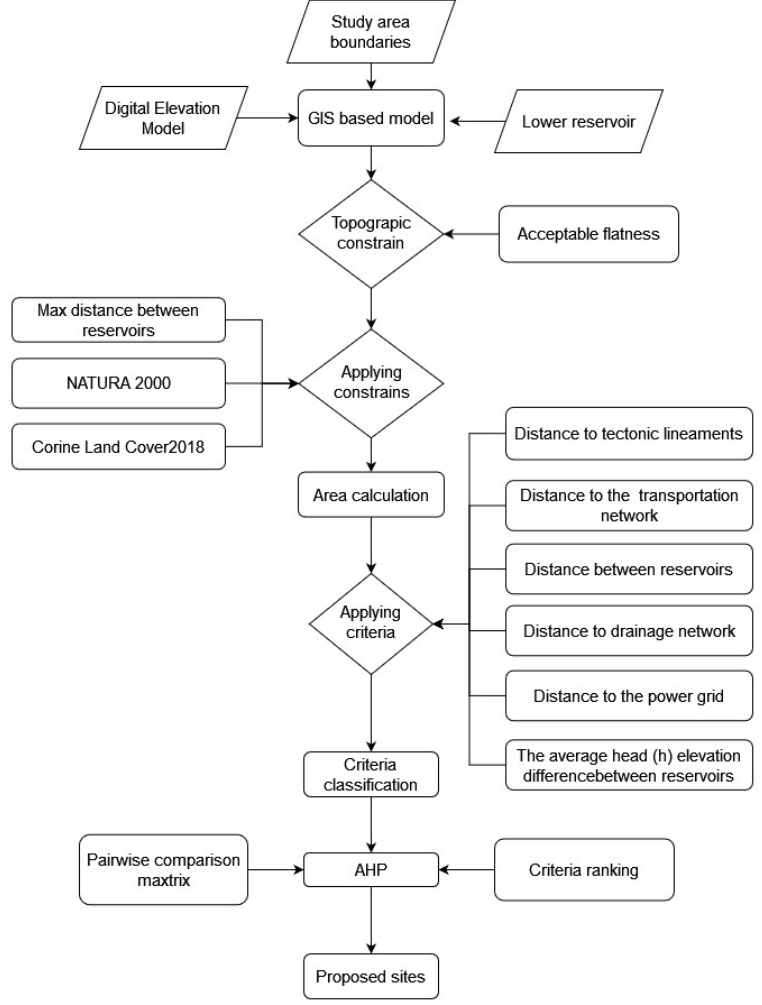
Figure 6. Schematic workflow of the geoprocessing tools that were implemented utilizing various datasets and adopting the analytical hierarchy process (AHP) approach.